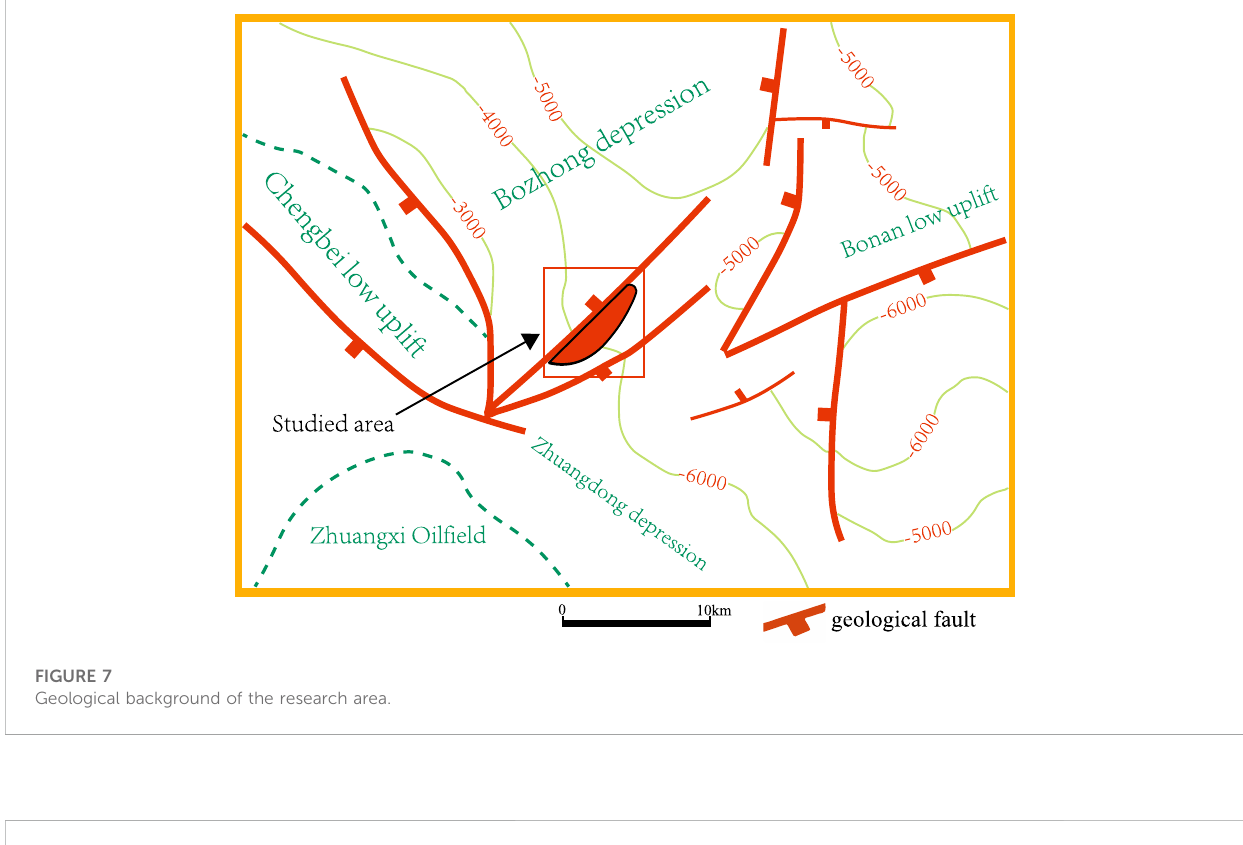
Original seismic section with manual interpreted